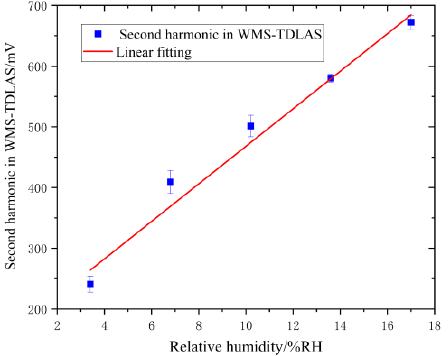
8 of 10 Figure 8. Second harmonic detection in the WMS-TDLAS mode. The concentration of heavy oxygen water vapor is proportional to the second har- monic of the transmitted intensity in the WMS-TDLAS mode. The relative humidity is a function of the maximum of the second harmonic. Figure 9 represents the linear fitting.